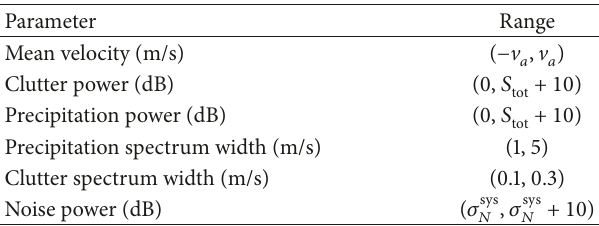
Table 2: Range of unknown